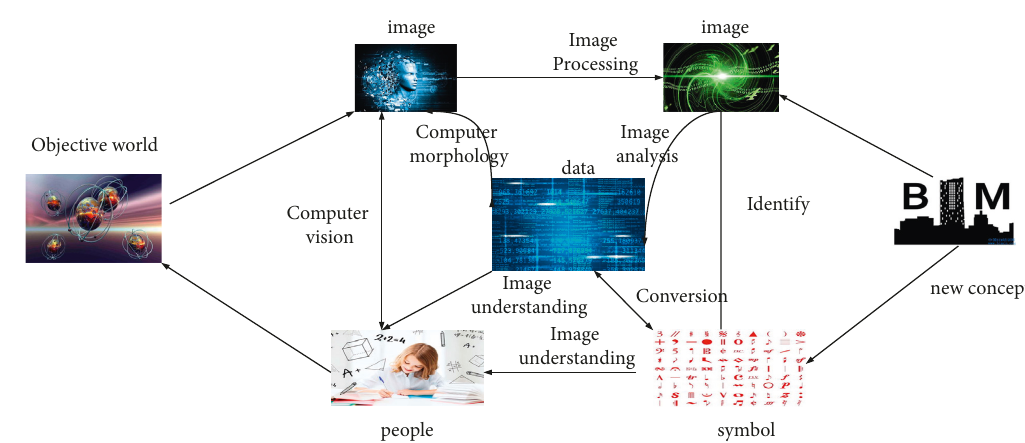
Figure 2: Schematic diagram of digital image processing.